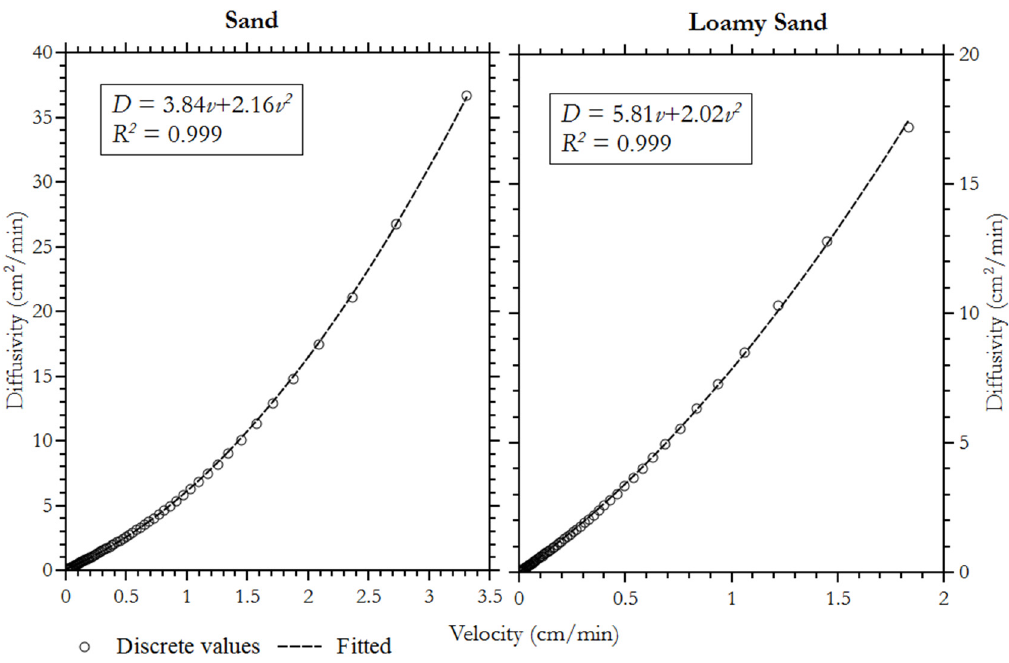
Figure 4. Parabolic relation between velocity and